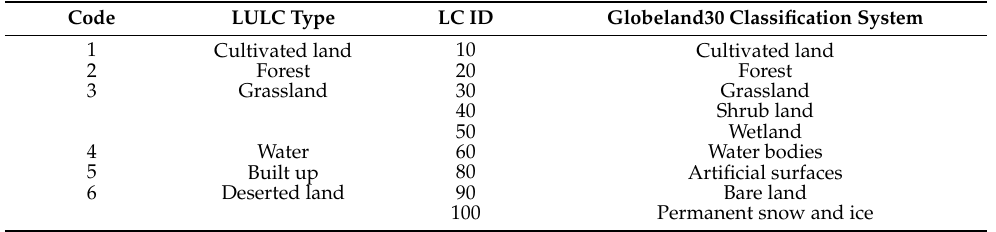
Table 1. LULC classification system in study area.